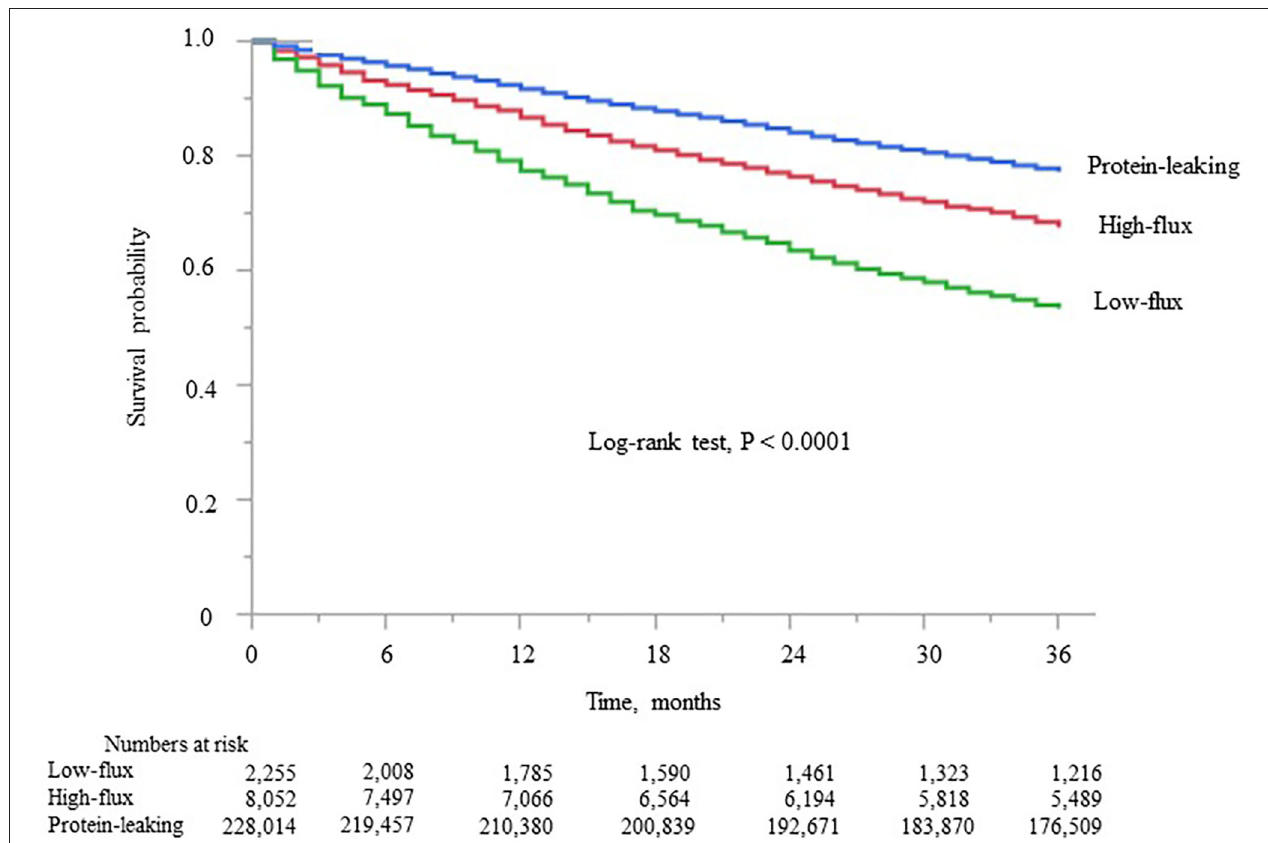
FIGURE 2 | Kaplan–Meier survival curve for all-cause mortality in the three dialyzer type groups in the international classification.